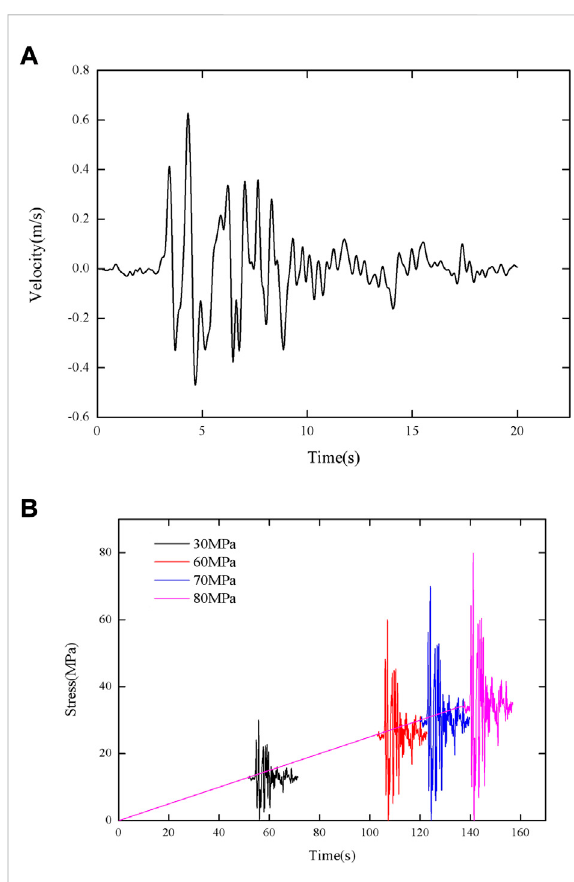
FIGURE 1 The velocity time history and load time history of Kobe seismic load with different maximum stresses: (A) Velocity time history; (B) Load time